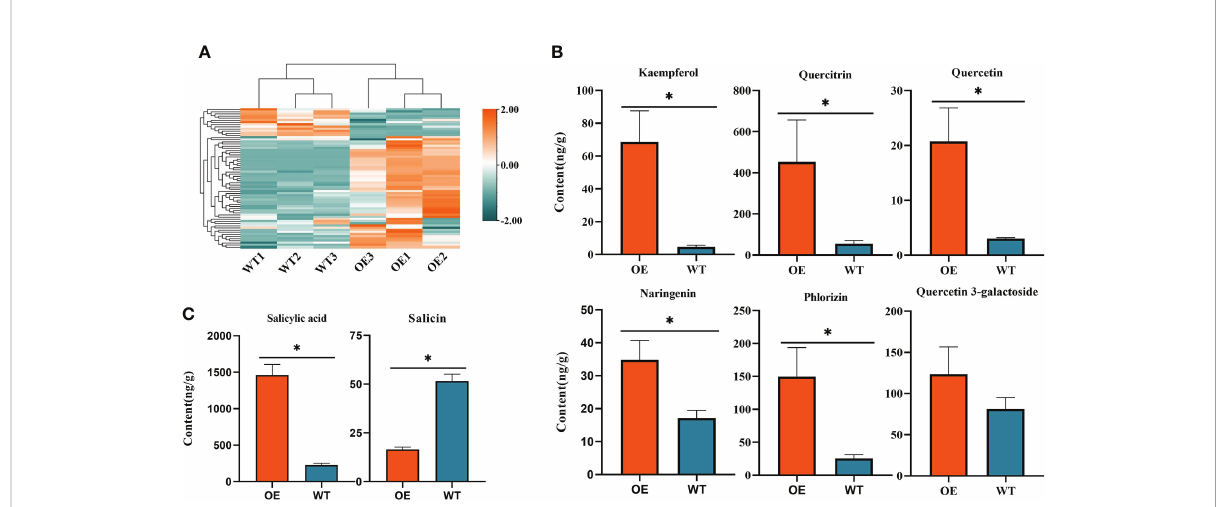
FIGURE 7 (A) Heatmap visualization of 65 fl avonoids. The content of each fl avonoid was normalized by row. (B) The contents of different fl avonoids in tobacco expressing CoDFR . (C) The salicylic acid content in tobacco expressing CoDFR . “ * ” indicate statistically signi fi cant differences ( P < 0.05) from the